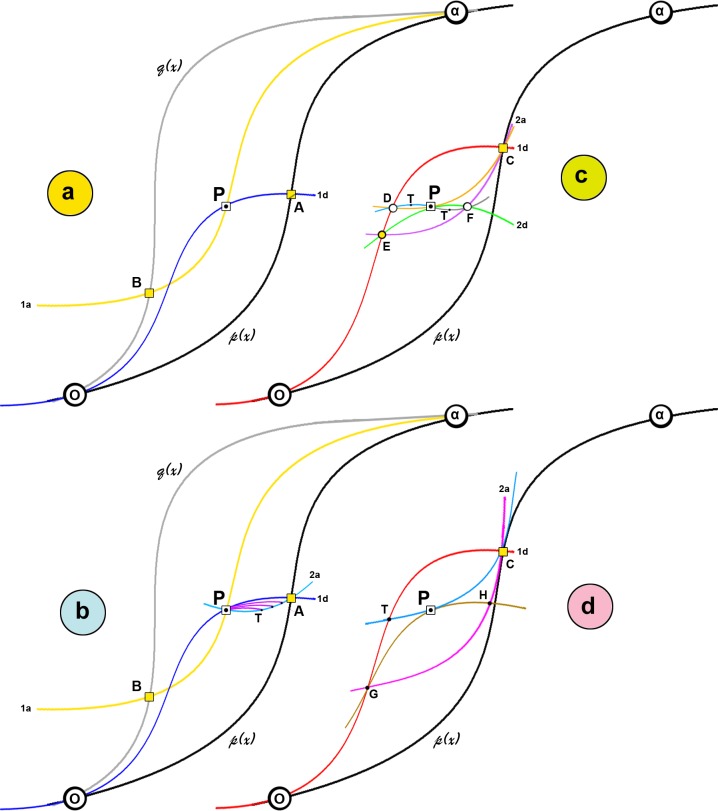
Different routes to a common point P; p(x) and q(x) are respectively the ascending and descending boundaries (i.e. adsorption/desorption branches); 1a and 1d denote primary ascending and descending curves; 2a and 2d denote secondary ascending and descending curves. Cognate paths are indicated and temporary points are denoted with T or T΄. In (c) and (d) the descending boundary has been omitted. See text for more details.